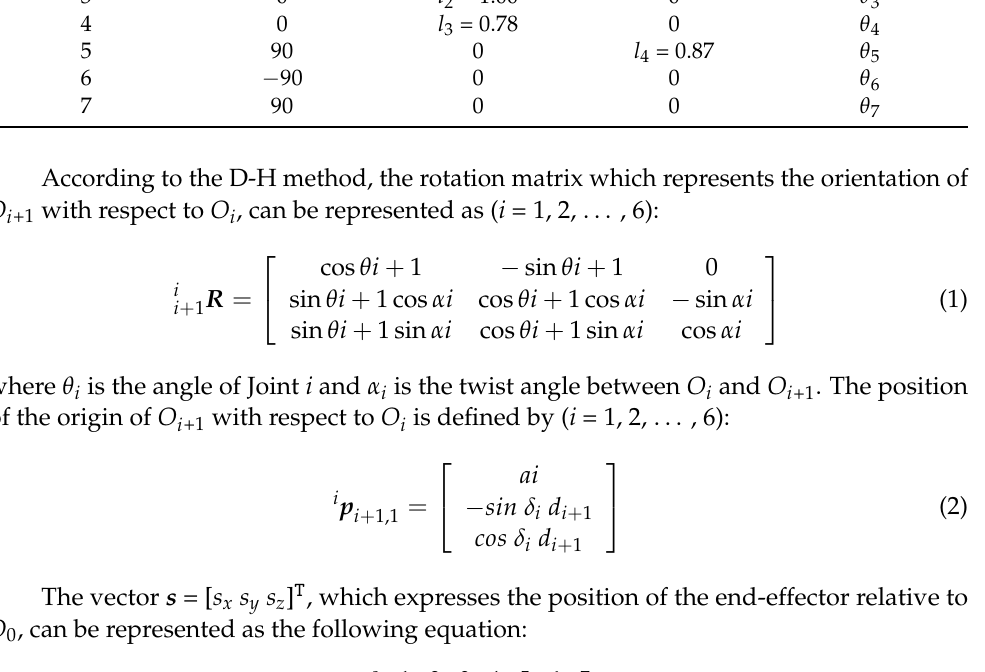
Table 2. I xx , I yy , I zz , I xy , I xz, and I yz represent the parameters in the inertia matrix of each